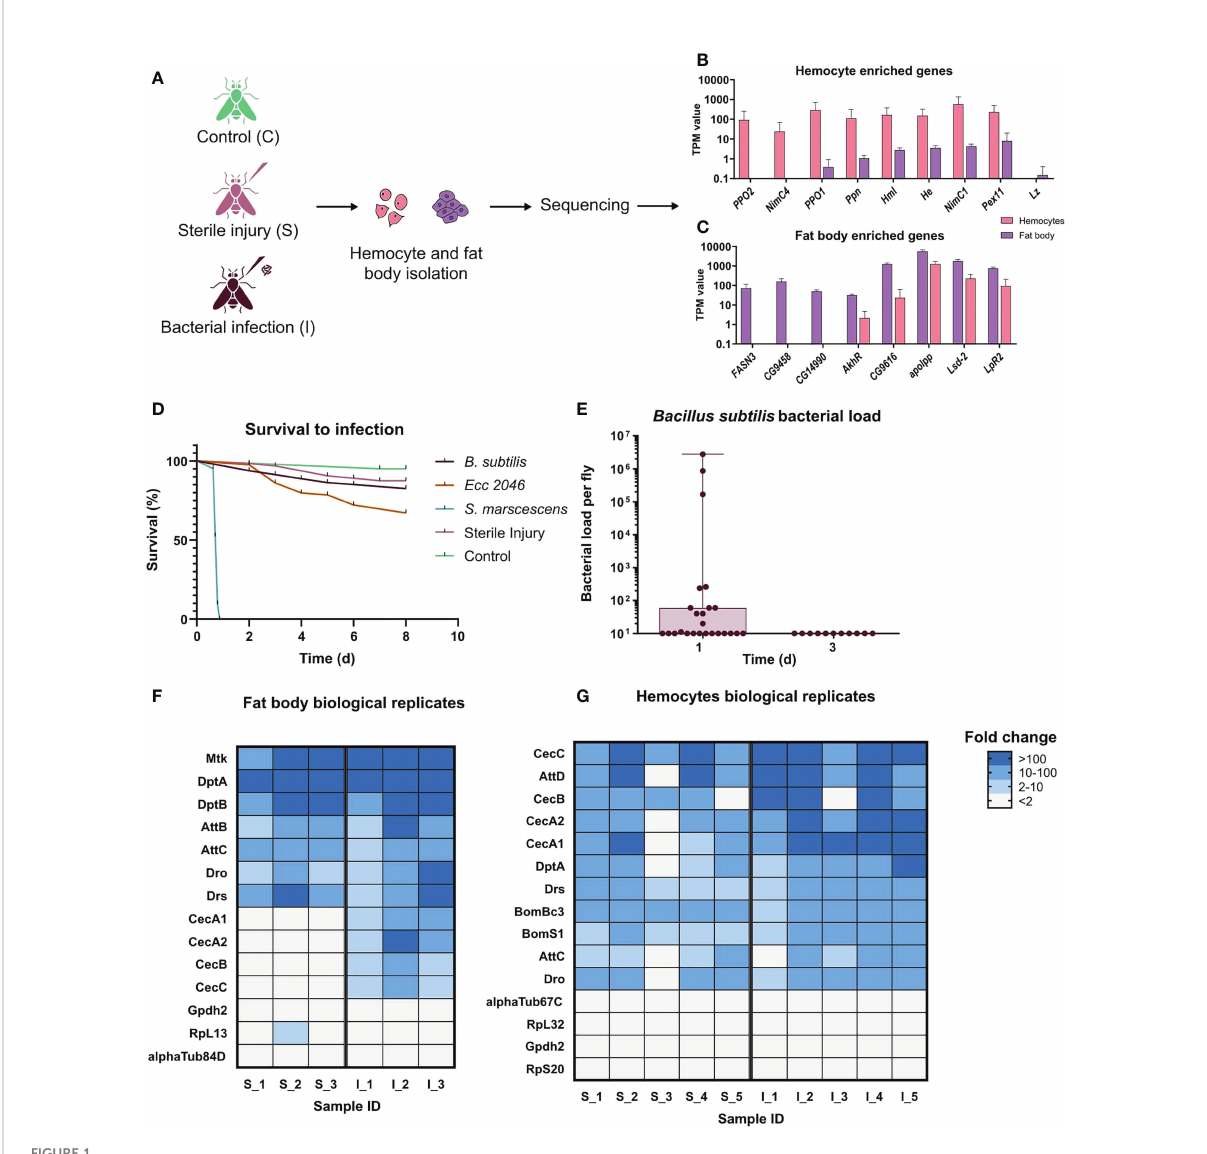
FIGURE 1 Experimental design of the systemic infection experiments. (A) Scheme showing the setup of the experiment. Samples were collected from control(C), sterile injury(S), and bacteria-infected (I) animals. Infections were performed using the bacterium Bacillus subtilis . Hemocytes and fat bodies were isolated 20 hours after infection, subjected to RNA extraction, cDNA synthesis, and ampli fi cation, and then sequenced. Three biological replicates were sequenced for fat body (one animal per replicate) samples and fi ve for hemocytes (hemolymph pooled from 5 animals in each replicate). (B) TPM values for some known hemocyte-enriched genes in both hemocytes and fat bodies samples. Most genes show more than 100-fold higher transcript numbers in the hemocyte samples, indicative for a highly pure hemocyte preparation. (C) TPM values for some of the most enriched genes in the adult fat body according to Flyatlas2 (32) in both hemocytes and fat body samples. All genes show much higher expression in the fat body samples, indicative for a highly pure fat body cell preparation. (D) The survival curve of fl ies subjected to the following treatments: Untreated Control (n=40), Sterile Injury (n=64), S. marcescens systemic infection (OD 600 0.01; n=30), Ecc2046 systemic infection (OD 600 15; n=82), Bacillus subtilis systemic infection (n=81). (E) Bacterial load of the fl ies 24 hours (n=25) and 72 hours (n=11) after infection with Bacillus subtilis . Each dot represents one animal, mean values ± S.D. (F) Heatmap of fold changes of read numbers for selected AMP and housekeeping genes in individual biological replicates for the injured and infected animals ’ fat bodies. A number at the end of the treatment name indicates the individual replicates: S_1, S_2 and S_3 are sterile injury and I_1, I_2 and I_3 are bacteria infected. Fold change was calculated relative to the average TPM value in the control fat body. (G) Heatmap of fold changes for selected AMP and housekeeping genes in individual biological replicates for the injured and infected animals ’ hemocytes. A number at the end of the treatment name indicates the individual replicates: S_1 - S_5 are sterile injury and I_1 - I_5 are bacteria infected. Fold change was calculated relative to the average TPM value in the control